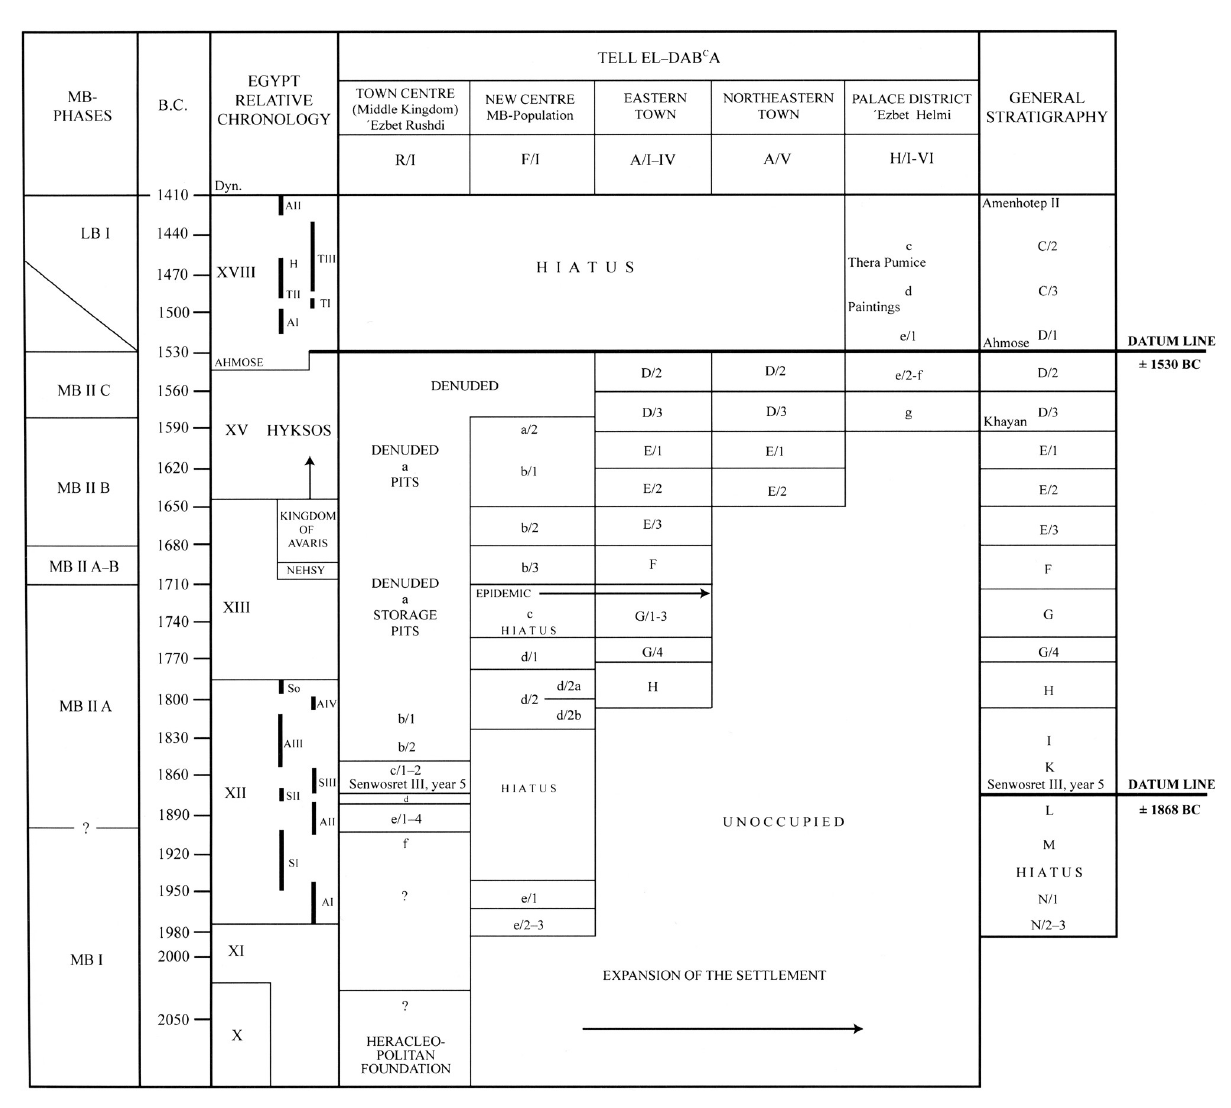
Fig 3. The site stratigraphy system. After